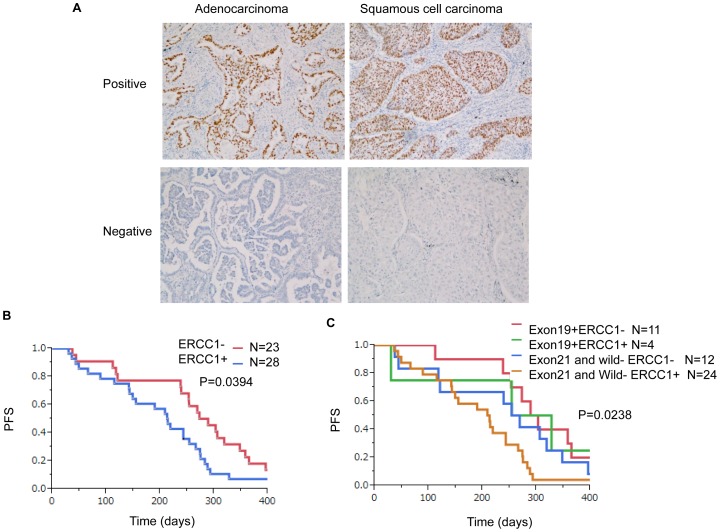
Immunohistochemical assessment of ERCC1 and correlation between ERCC1 and survival.A: Expression of ERCC1 was assessed by immunohistochemistry. Expression of ERCC1 protein was detected in the nuclei of cancer cells (x400). B: Kaplan-Meier survival curves according to ERCC1 expression score. C: ERCC1-negative patients with exon 19 deletion had longer PFS than the others, and ERCC1-positive patients without exon 19 deletion had shorter PFS than the others.